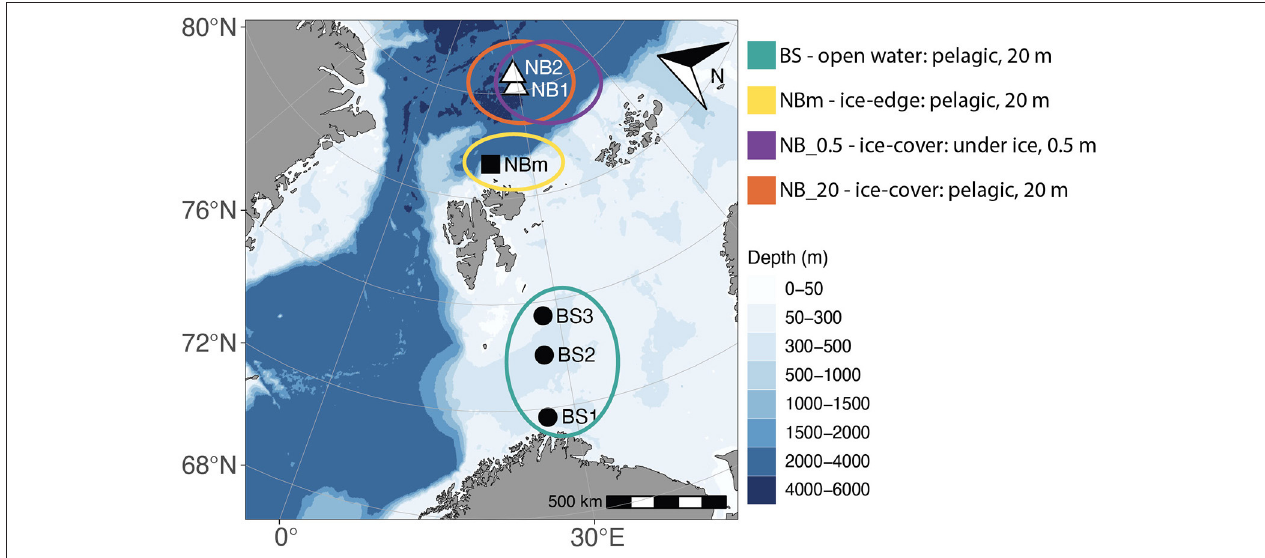
FIGURE 1 | A Map showing the geographical location of sample stations—south and north of Svalbard. Samples were collected from surface water, 20m, at all stations (•, Barents Sea stations: BS1, BS2, and BS3; (cid:4) , sea-ice edge station in Nansen Basin margin: NBm; △ , sea-ice covered stations in Nansen Basin: NB1 and NB2). In addition, at NB1 and NB2 stations, samples were collected directly under sea ice,0.5m. The colored circles represent sample locations that were grouped based on the environment type: BS (green), Barents Sea communities in the open water environment; NBm (yellow), Nansen Basin margin community in sea-ice